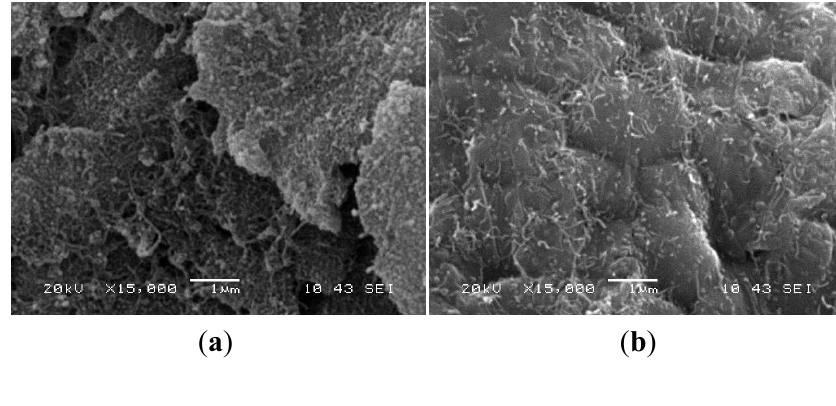
O nanocomposite powder ball milled for 9 h. 2 3